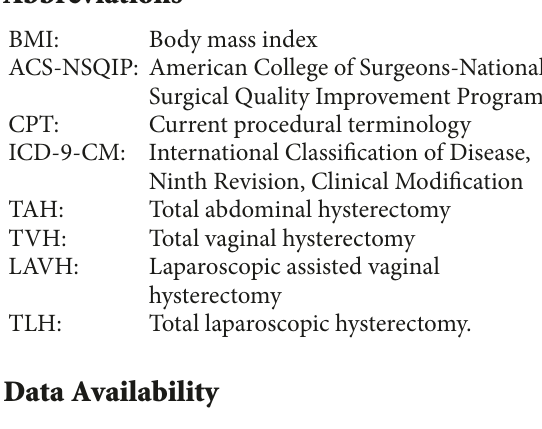
Table S1: perioperative outcomes among uterine cancer patients with ideal BMI, stratified by route of hysterec- tomy, ACS-NSQIP, 2005-2013. Table S2: perioperative out- comes among uterine cancer patients with overweight BMI, Table S3: perioperative outcomes among uterine cancer patients with obese BMI, stratified by route of hysterectomy, ACS-NSQIP, 2005-2013. Table S4: perioperative outcomes among uterine cancer patients with morbidly obese